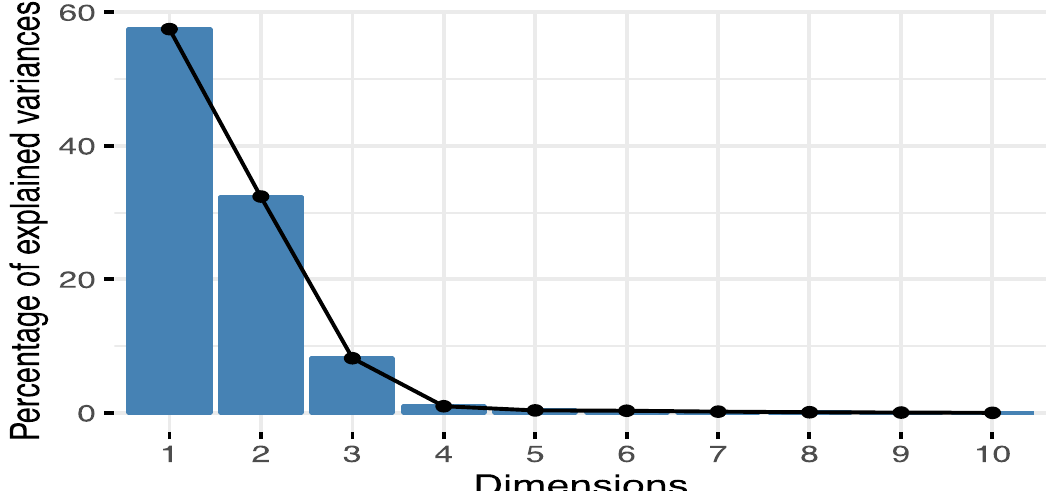
Figure A7. Proportion of the variance explained by the principal components of the PCA of environmental variables. Each bar represents % variance explained by a principal component. Most of the variance is explained by the first two principal components.